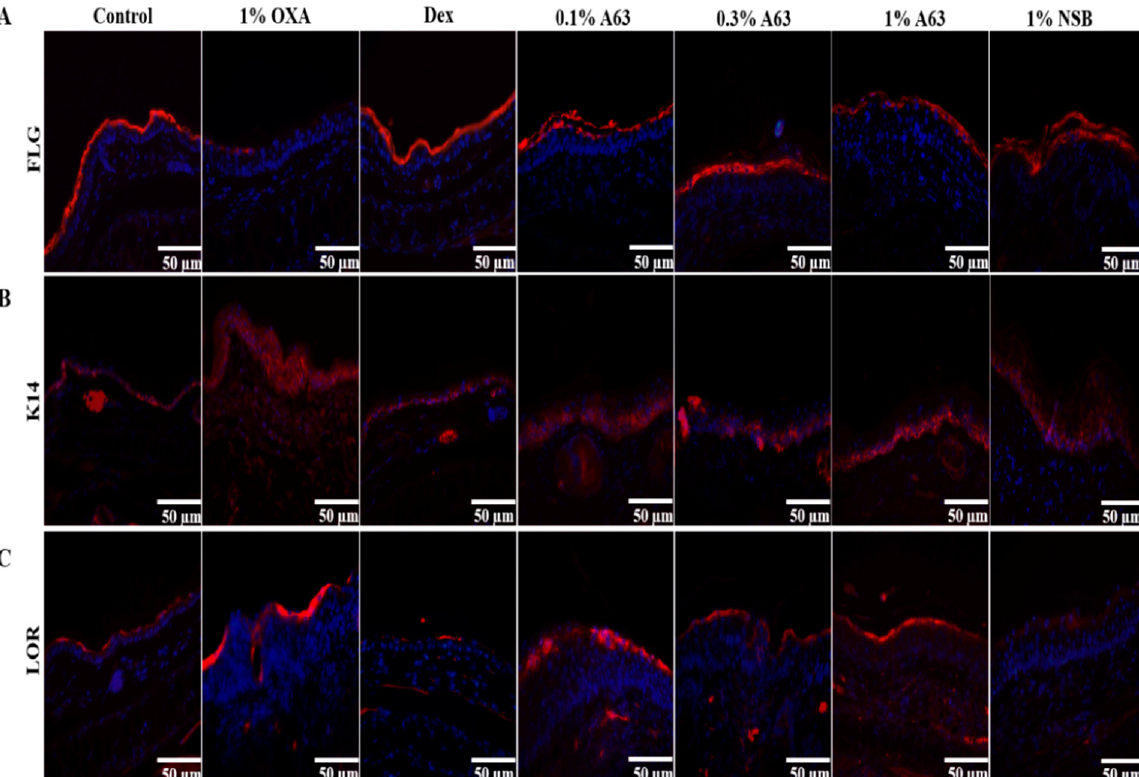
Figure 3. A63 extract application enhanced the restoration of normal skin integrity. Immunohisto- chemical analysis of ears in an OXA-induced AD murine model. A63 extract treatment increased expression of skin barriers components, filaggrin (A, FLG), keratin 14 (B, K14) and loricrin (C, LOR) in OXA-triggered mice similar to the Dex group (scale bar = 50 µm). OXA, oxazolone; AD, atopic dermatitis; Dex, dexamethasone.